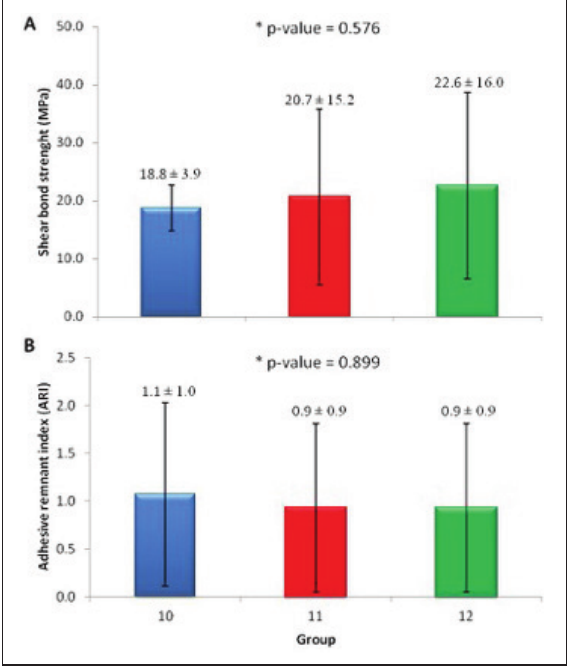
Figure 4. Comparison of shear bond strength (A) and ARI (B) between groups. Columns represent means, and error bars the standard